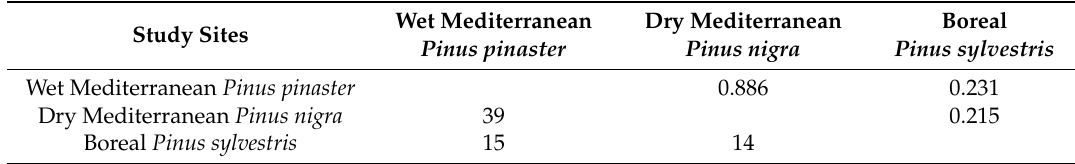
Table 2. Jaccard similarity coefficients (lightface) and the number of genera in common (boldface) among the three different study